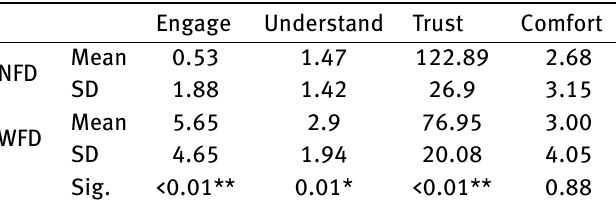
Table 5: Influence of feedback implemented on QoI variables.